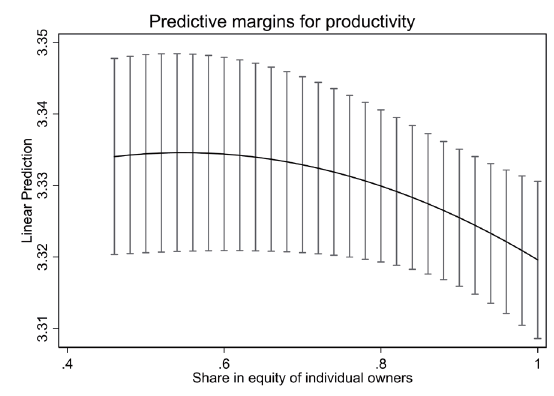
Fig. 2 – Marginal effects of share of individual owners in equity on TFP. Source: own research